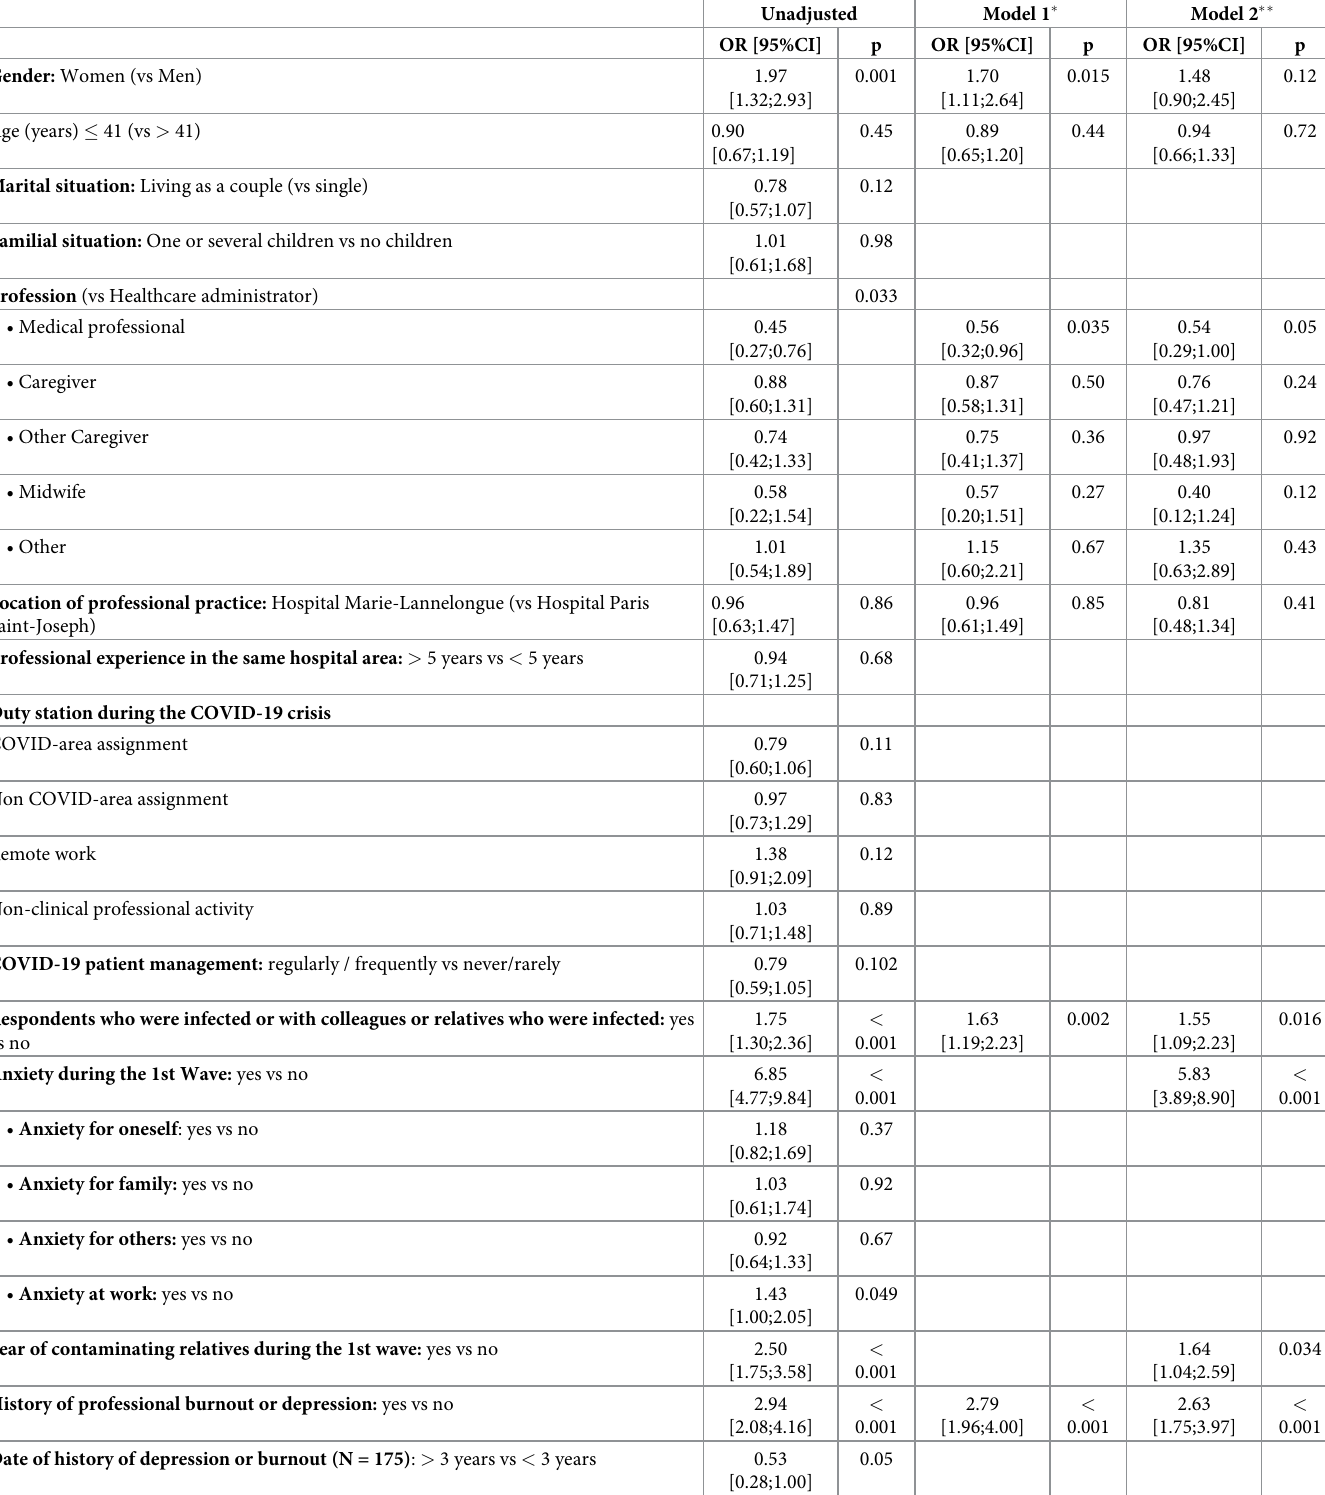
Table 2. Unadjusted and adjusted logistic regression for symptoms of anxiety (HADa > 7), n =